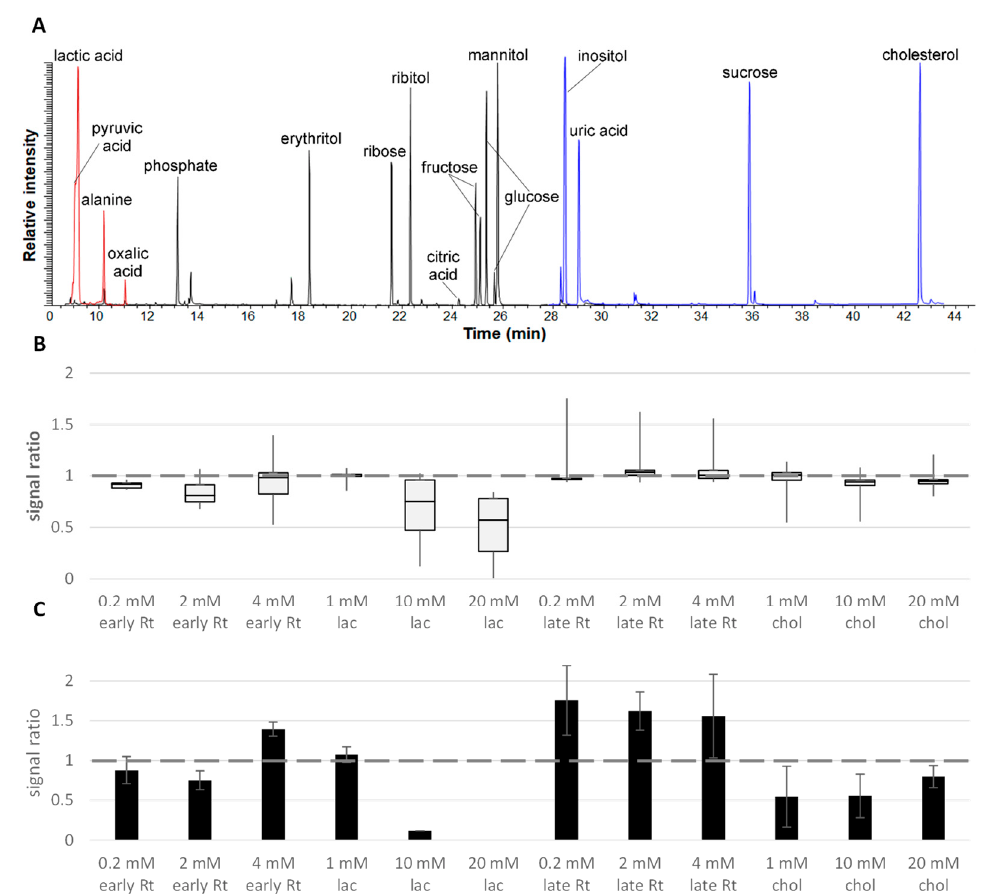
Figure 6. Signal behavior in presence of early and late eluting compounds in saturation. ( A ) Elution profile of the compounds used in order of retention: the early eluting derivatives of pyruvic, lactic, alanine, and oxalic acids in red (glyoxylic acid elutes within the solvent delay); phosphate, erythritol, ribose, ribitol, citric acid, fructose, glucose, and mannitol in the intermediate range (black); and four semi-volatile derivatives of inositol, uric acid, sucrose, and cholesterol (blue; a derivative of glycerophosphoglycerol was not detected; instead, degradation products such as glycerol phosphate were identified). ( B ) Boxplots illustrating signal ratio distribution for derivatives of intermediate retention (phosphate, erythritol, ribose, ribitol, citric acid, fructose, glucose, and mannitol, each 50 µM) challenged by addition of early and late eluting compounds at the stated concentration. Early eluting compounds produced a stronger suppression. ( C ) Profile of citric acid 4 TMS signal interaction with early and late eluting compounds. Lactic acid and cholesterol were suppressed, and the late eluting compound mixture enhanced the signal. Analyzed on a Trace Focus GC. Rt—retention time; lac—lactate; chol—cholesterol.